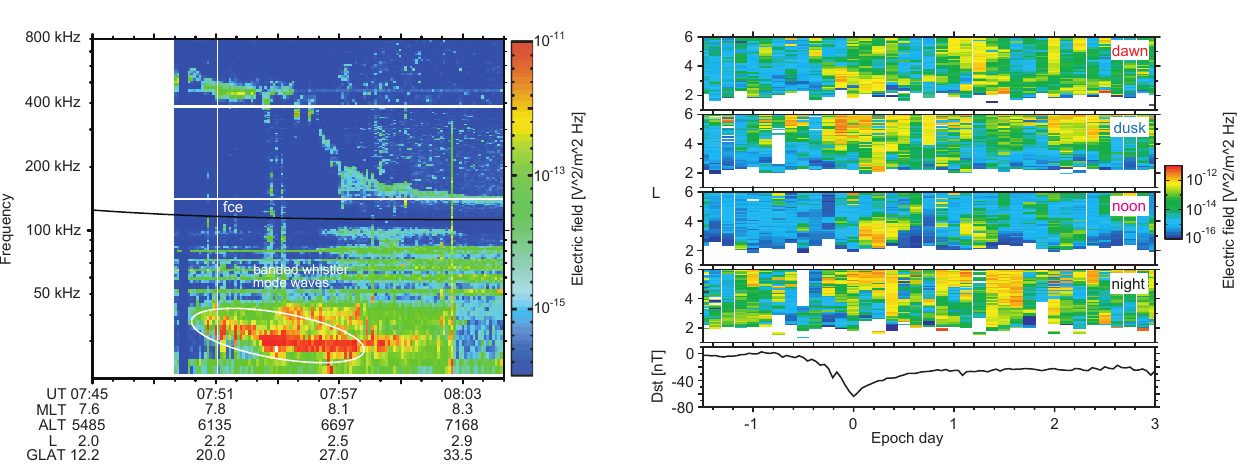
Fig. 5. Power spectral density of plasma waves observed by the Akebono satellite during day 101 of 1997. The solid line shows the local electron gyrofrequency. The white circle indicates banded whistler mode waves.